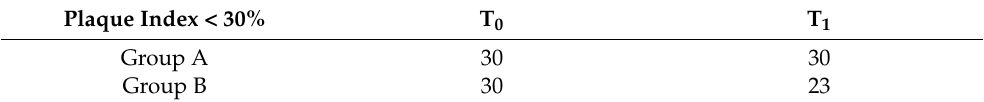
Table 2. Patients with plaque index less than 30% at first (T 0 ) and second (T 1 ) evaluation. Plaque Index < 30% T 0 T 1 Group A 30 30 Group B 30 23